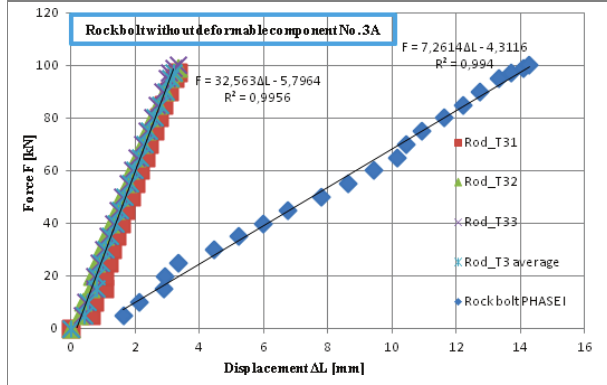
Fig. 31. Detailed loading characteristics for the components of the rock bolt support No. 3A